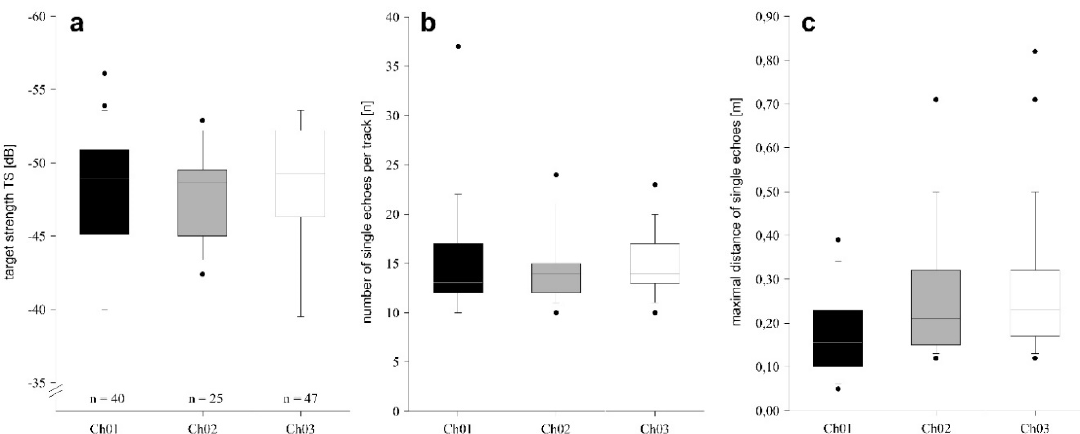
Figure 4. Results (box plots: line = median, black dots = outliers) from the fish detection test for each of the three channels (Ch01 = right, Ch02 = middle position, Ch03 = left). ( a ) target strength TS [dB]; ( b ) number of single echoes per track [n]; ( c ) maximal distance of single echoes [m].